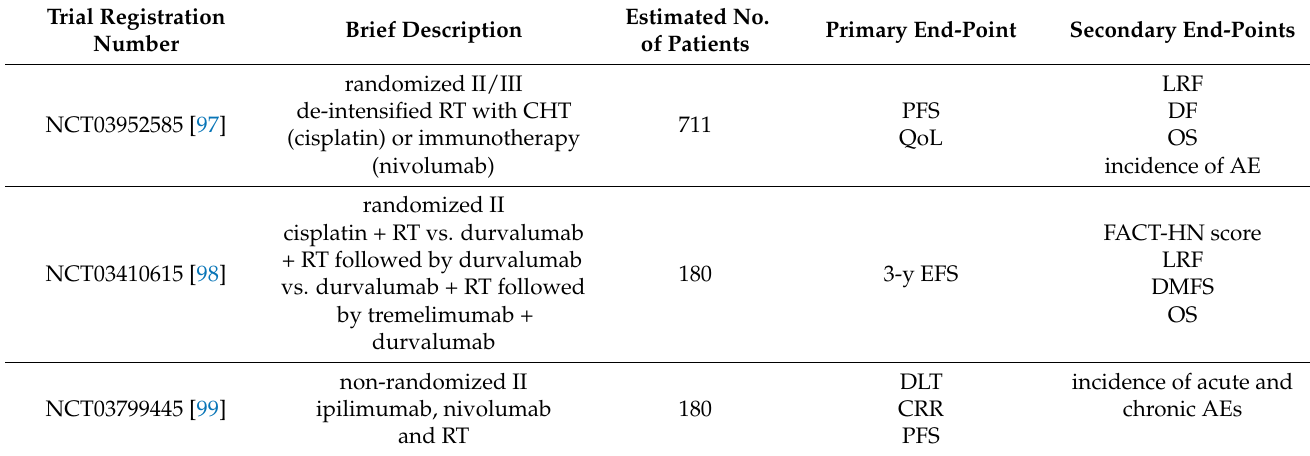
Table 3. Ongoing clinical trials in HPV+